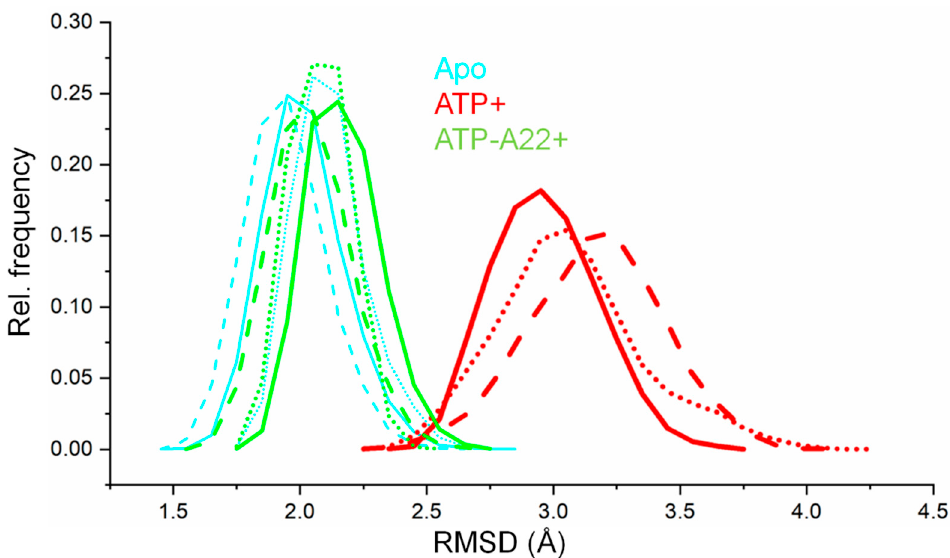
Figure 2. Backbone-atom root mean square deviation (RMSD) distribution curves of apo, ATP+, and ATP-A22+ MreB. The solid, dashed, and dotted cyan lines represent backbone RMSD distributions of chain B from simulations 1, 2, and 3, respectively, of the apo filament. The solid, dashed, and dotted red lines represent backbone RMSD distributions of chain B from simulations 1, 2, and 3, respectively, of the ATP+ filament. The solid, dashed, and dotted green lines represent backbone RMSD distributions of chain B from simulations 1, 2, and 3, respectively, of the ATP-A22+ filament.